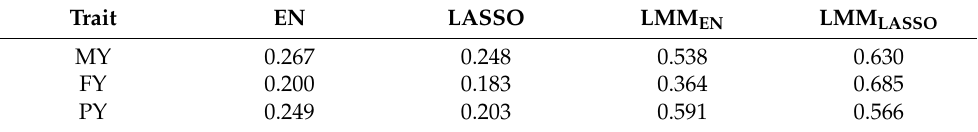
Table 3. Validation regression coefficients of GS with different feature selection